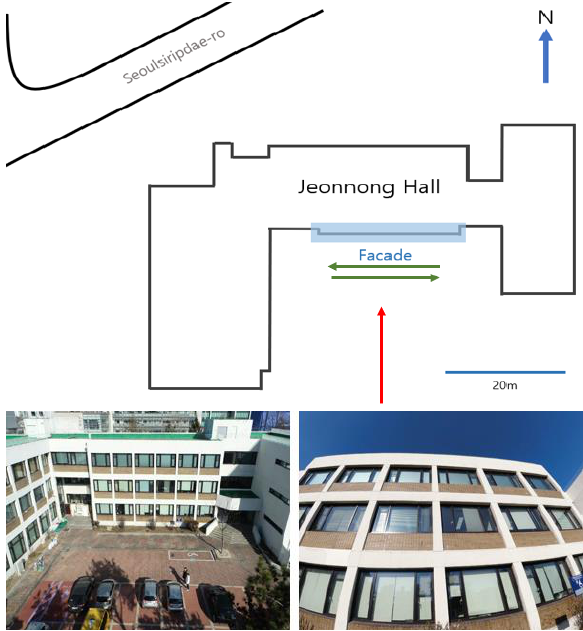
Figure 4. Red arrow shows how RTK drone moves from the south to the north, and the lower left is an image taken by the drone. Green arrows are the action camera flow line. The lower right is an image taken by the action